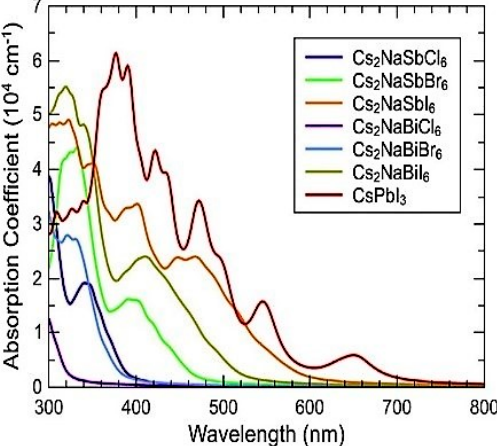
Figure 6. Optical absorption spectra for the Cs 2 NaBX 6 double perovskites (B = Bi, Sb; X = Cl, Br, I). Reproduced with permission from Reference [44]. Elsevier, 2018.